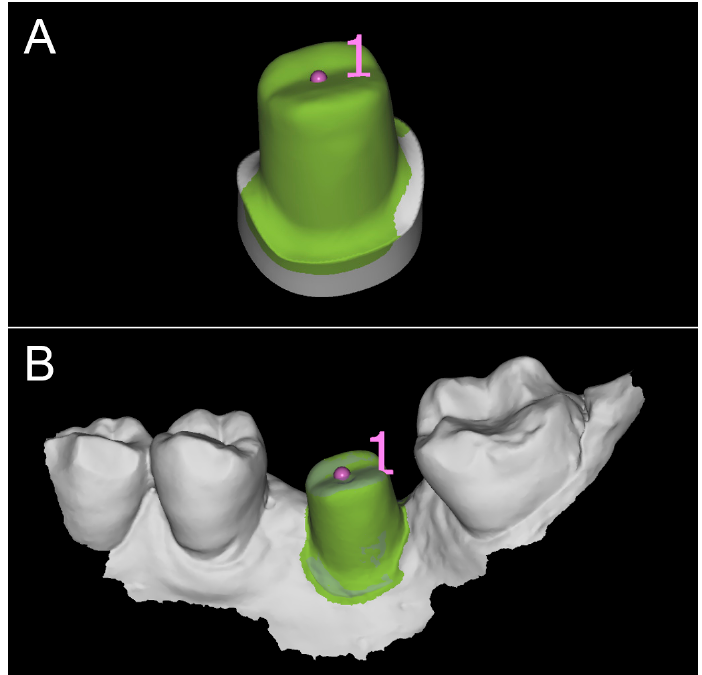
Figure 9. Superimposition. ( A ) the mesh captured in the mouth is replaced by the original CAD drawing. The superimposition proceeds first per points and then per surfaces; ( B ) The mesh (a geometric approximation of the object) is replaced by the original CAD drawing, so that the subgingival margins of the abutment become visible.